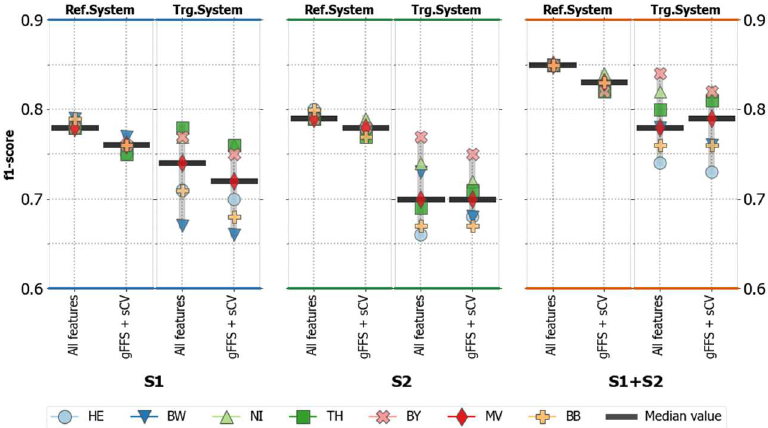
Figure 6. Overall F1-scores of classifications based on three feature sets, with variants of using all features and spatial feature selection. The abbreviation keys are provided in Table 2.